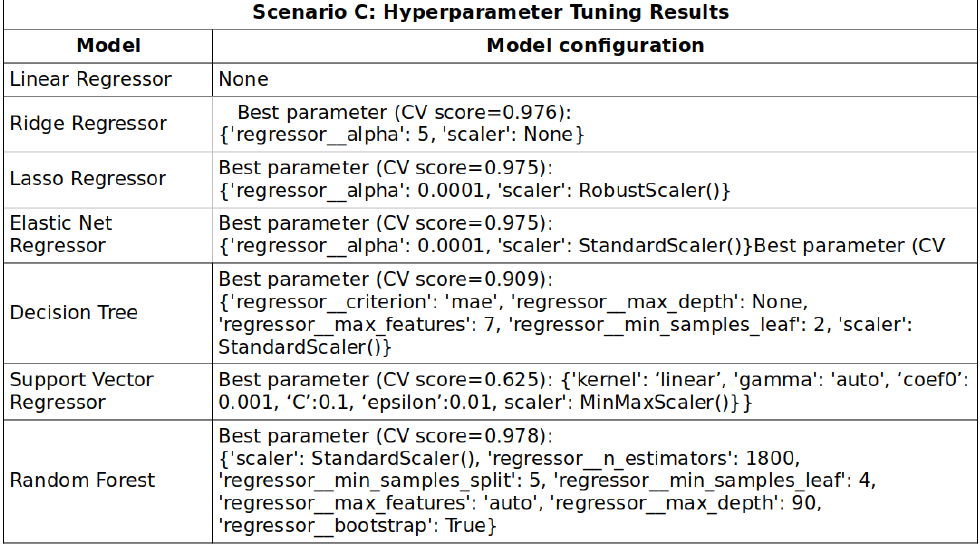
Figure A3. Hyperparameter configuration for the models of Scenario